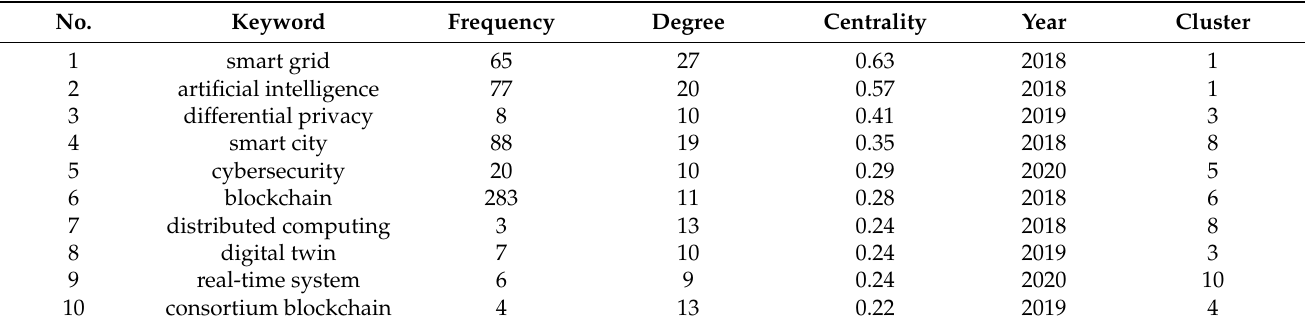
Table 4. Top ten keywords with highest betweenness centrality.